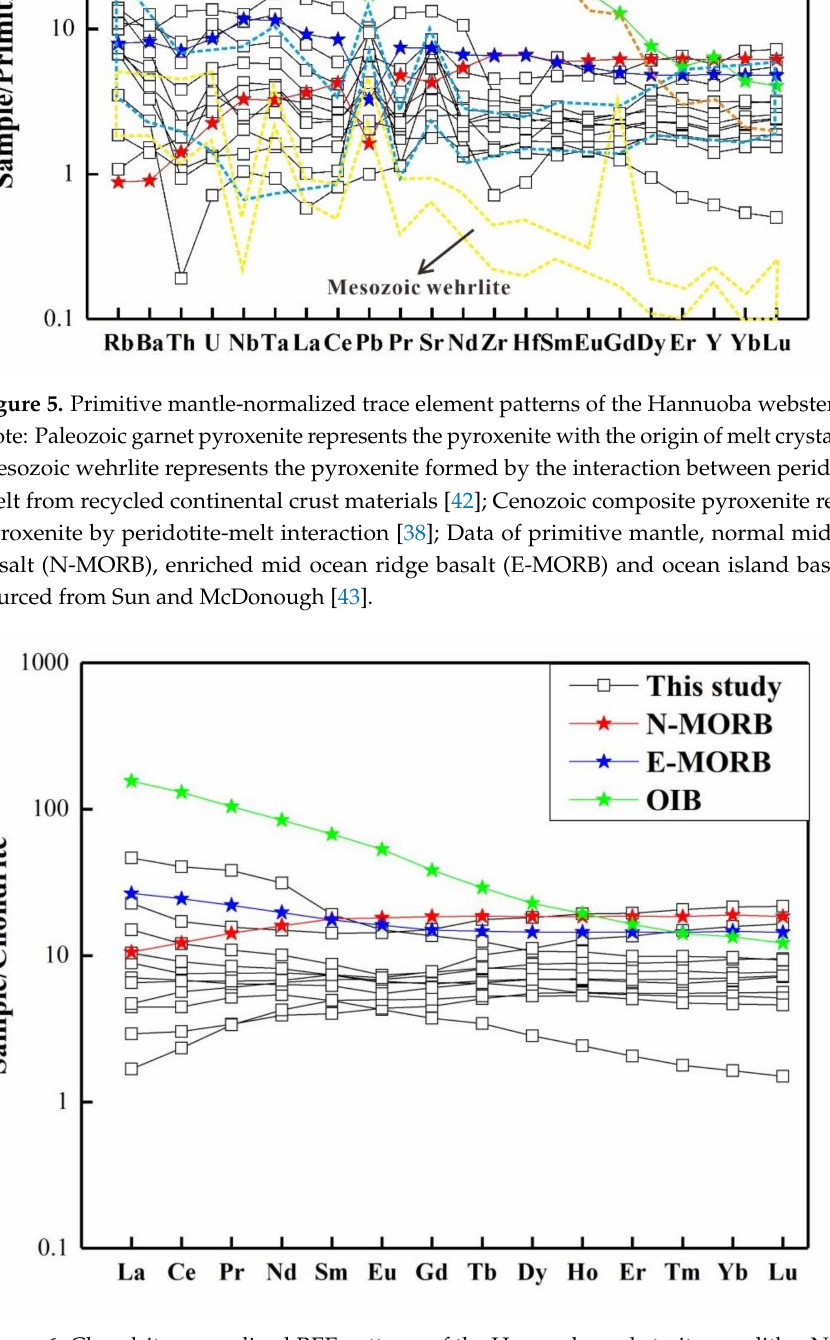
Figure 6. Chondrite-normalized REE patterns of the Hannuoba websterite xenoliths. Note: The data for the primitive mantle, N-MORB, E-MORB, and OIB are the same as Figure